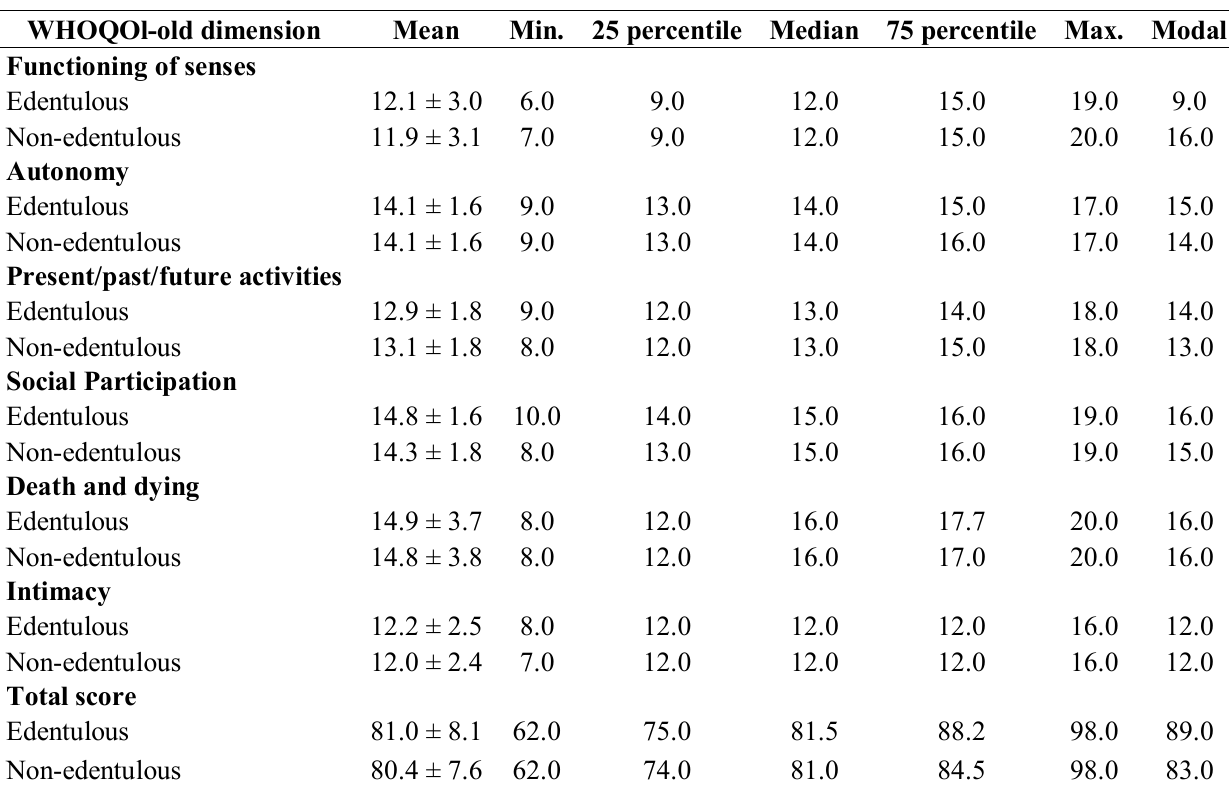
Table 2. Distribution of scores on the WHOQOL-Old dimensions according to presence or absence of edentulism among elderly individuals (n = 163).